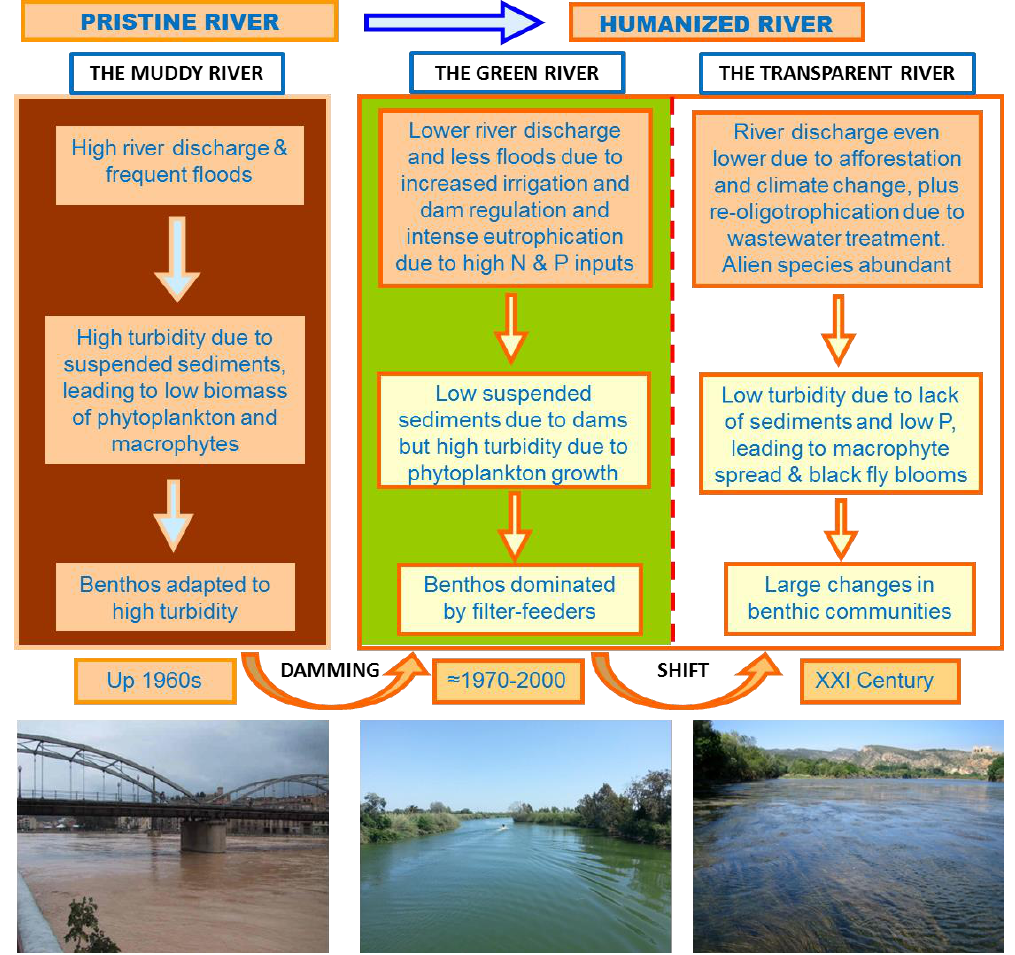
Figure 2. Conceptual model showing the main human impacts and changes in the ecosystem that the lower Ebro River has suffered in the last 60 years. lower Ebro River has su ff ered in the last 60